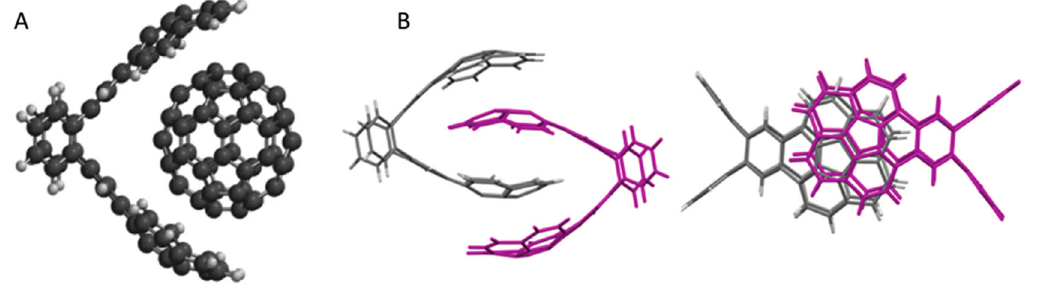
Figure 15. ( A ) Concave-concave buckycatcher around C 60 ; ( B ) Interdigitated concave-concave buckycatchers. Adapted from [161] with permission from the American Chemical